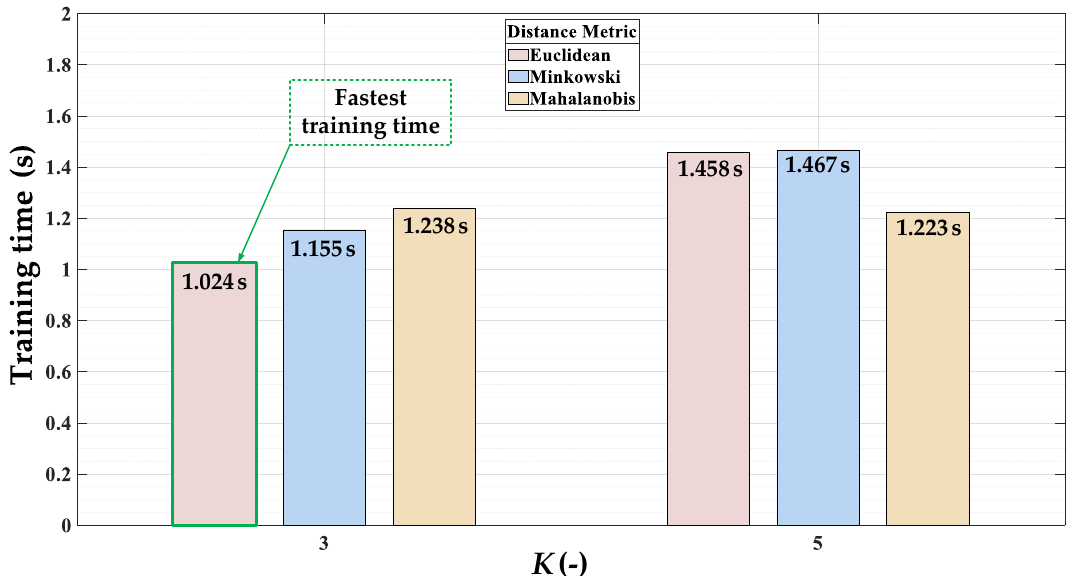
13 of 21 Table 2. The KNN classifier accuracy for selected key parameters. K (-)